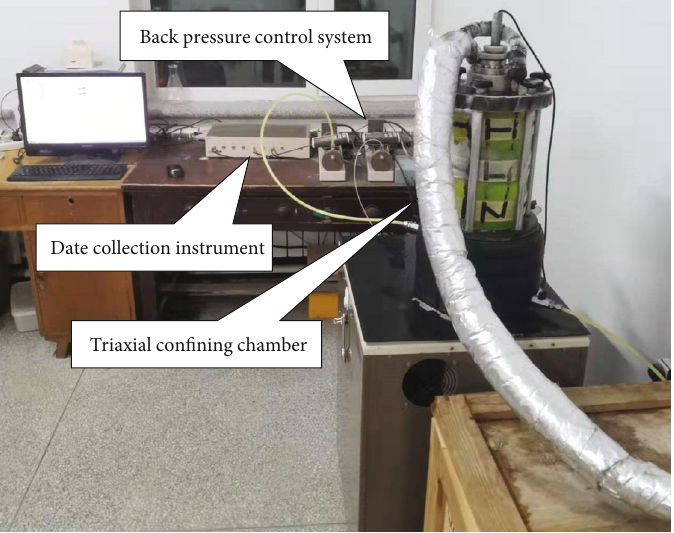
Figure 5: GDS triaxial test apparatus.